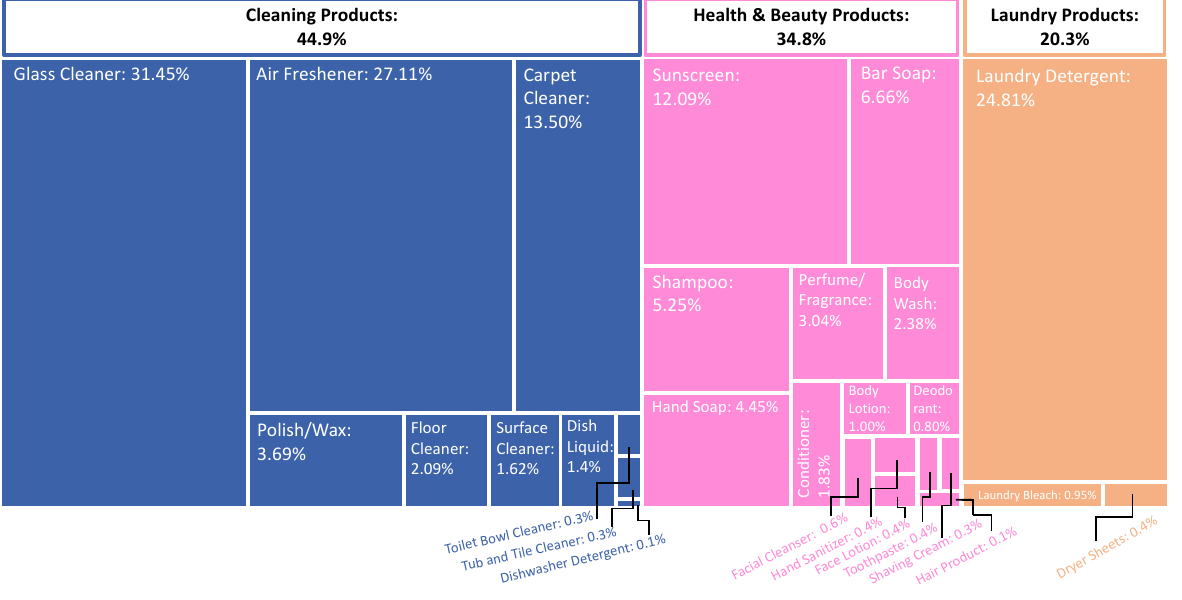
Figure 5. Average percentages of the contribution of each product to the overall footprint of cleaning products, health and beauty products, and laundry products, with products in the cleaning, health and beauty, and laundry categories, contributing an average of 44.9%, 34.8%, and 20.3%, respectively, to the total EDC footprints of the 39 participating citizen scientists. The size of each rectangle provides a visual representation of the extent to which that product contributes to the total footprint.